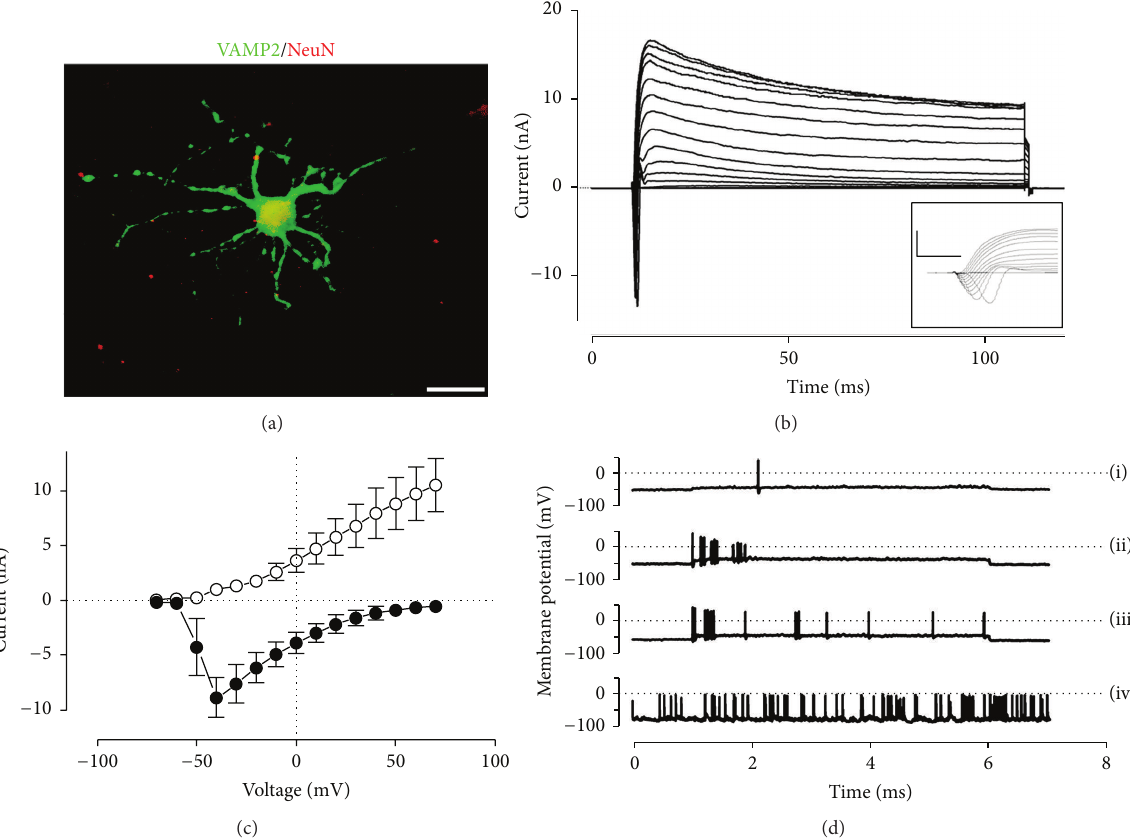
Figure 3: Mature neurons from SMINS-TTF-3 cells. (a) SMINS-TTF-3 cells were cultured in mature neural medium for one month and stained by mature neuron markers VAMP2 (green) and NeuN (Red). (b) Electrophysiological investigations of a subset of long-term differentiated cells showed the presence of both inward Na + currents and outward K + currents in response to electrical stimulation with steps from − 70 to +70mV (10mV increments) from a holding potential of − 80mV. Representative trace with 100ms steps, inset with 20ms steps (inset scale bars represent 5 ms on 𝑥 -axis, 10nA on 𝑦 -axis). (c) Mean ± SEM maximal Na + (closed circles) and K + currents (open circles, 𝑛 = 4 ). (d) These cells demonstrated action potential firing in response to current injection ((i) 20 pA for 5 s, (ii) and (iii) 50 pA for 5 s) or spontaneously (iv). Scale bar: 10 𝜇 m